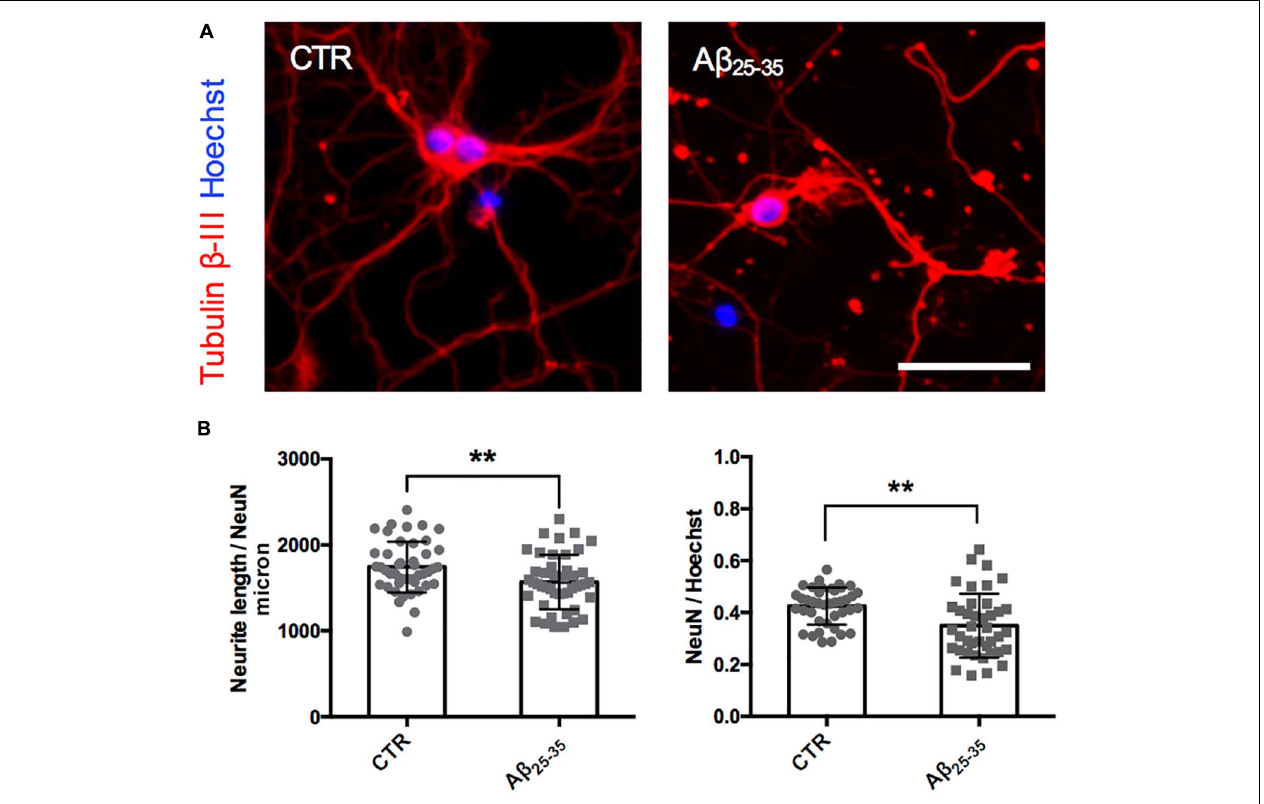
FIGURE 2 | Neurite atrophy in an in vitro model of A β injury. (A) Representative microscopy images (10X) of DIV7 hippocampal neurons in control condition (left) and after 24 h of A β 25 - 35 (10 µ M) treatment (right) stained with anti-Tubulin β -III (red) and Hoechst (blue). Scale bar = 50 µ m. (B) Scatter plot of total neurite length (TNL) for each neuron (left) expressed in µ m/neuron, and neuronal density expressed as the ratio between the number of neurons on the total number of cells (right) . Each dot represents TNL from an image (10X) in control and after 24 h of A β 25 - 35 (10 µ M) treatment, n = 40–45 fields per condition from three independent experiments. Following D’Agostino and Pearson’s normality test, we performed an unpaired t -test. ** p <